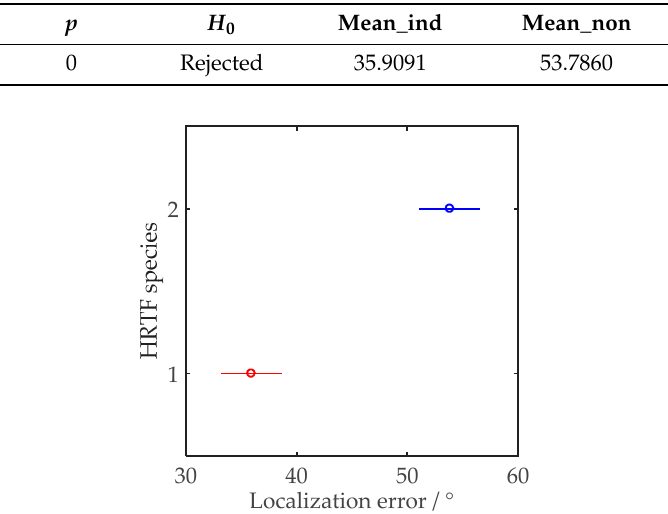
Figure 14. The result of post-hoc for ANOVA. X-axis denotes the localization errors. Y-axis denotes the testing HRTF species of (1) individualized HRTFs and (2) non-individualized HRTFs. Red and blue lines denote the HRTF species of individualized one and non-individualized one, respectively. Circles on the lines denote the mean class of the corresponding HRTF species. The lengths of the lines denote the mean confidence intervals of the corresponding HRTF species.